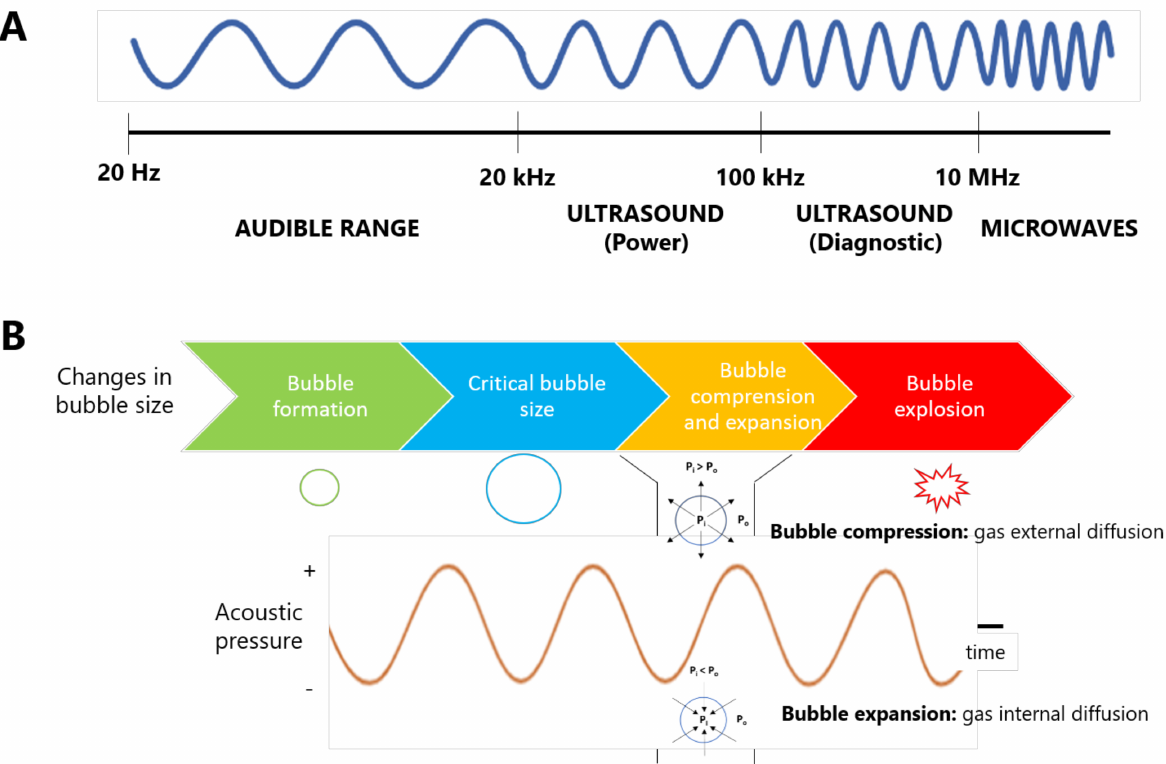
Figure 1. ( A ) The sound spectrum: audible range (20 Hz–20 kHz), ultrasound range (20 kHz–10 MHz) and microwave range (>10 MHz). ( B ) Bubble growth cycle during acoustic cavitation. Rarefaction and compression. A cycle of ultrasonic wave holds an expansion (rarefaction) and compression phases. In rarefaction phase, gas diffused into a bubble because of external pressure (P o ) is higher than internal pressure (P i ). However, gas diffused out of bubble during compression phase due to internal pressure is higher than external